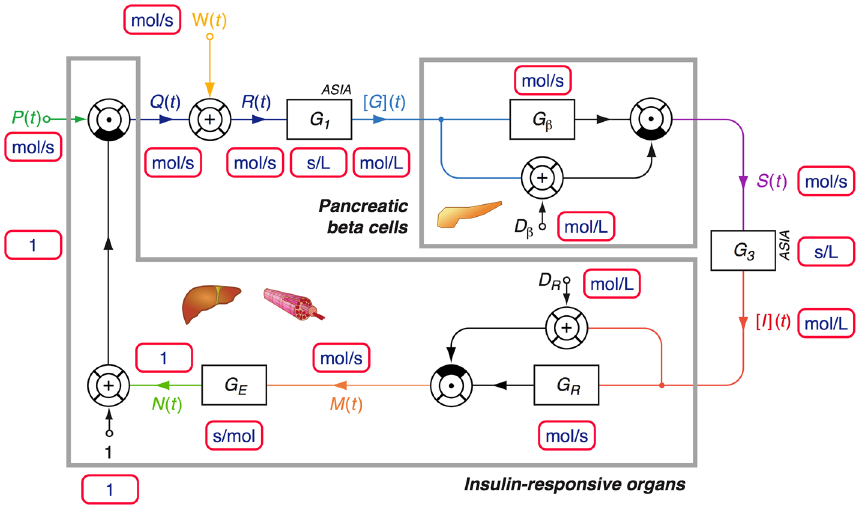
Figure 1. Information processing structure of the feedback model. [G](t): glucose concentration; S(t): insulin secretion rate; [I](t): insulin concentration; M(t): proximal insulin signalling; N(t) distal insulin signalling; P(t): constitutive glucose production rate; Q(t): regulated glucose production rate; W(t): intestinal glucose absorption rate; R(t): glucose arrival rate. G 1 and G 3 represent gains of ASIA elements (see text for their derivation). Units of measurement are displayed in the small rounded boxes with red